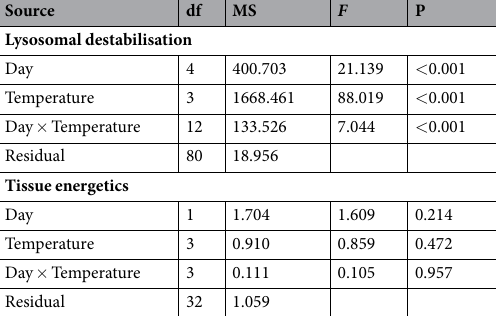
Table 2. Summary statistics of two-factor ANOVA for lysosomal destabilisation and tissue energetics of G. barretti explants exposed to different experimental temperature treatments (7, 9, 11 and 12 °C) over a 14 d period, followed by a two month recovery period (12 h, 24 h, 7 d, 14 d and